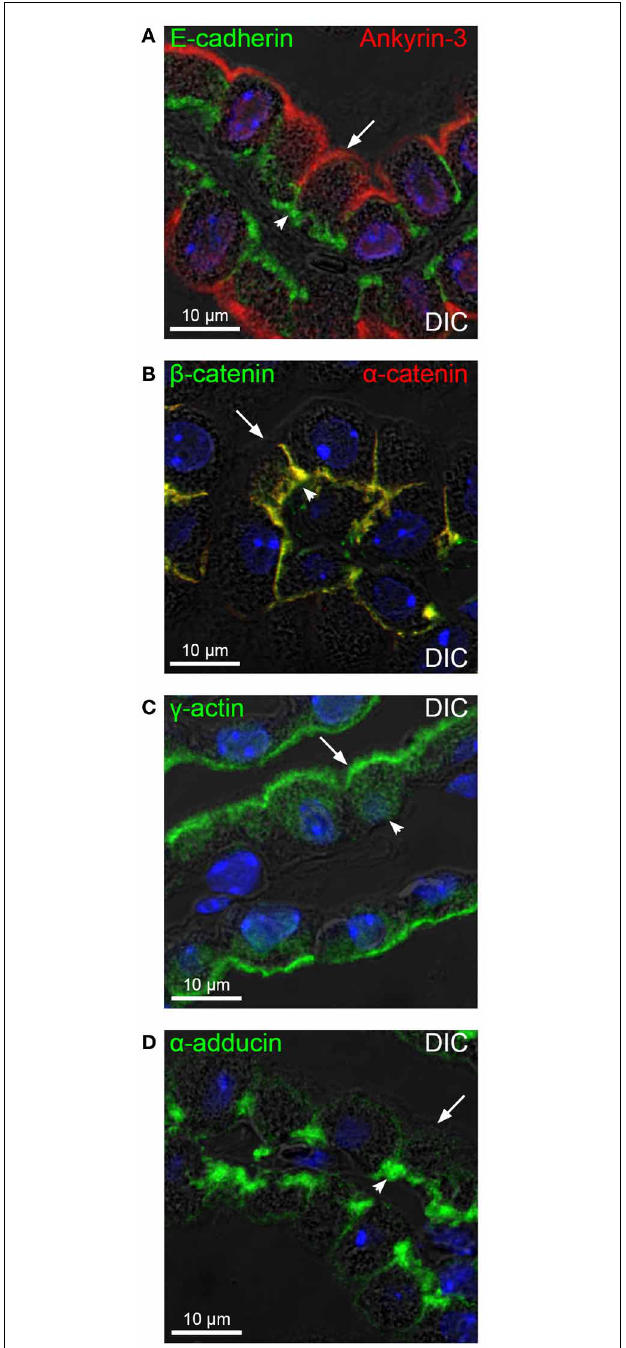
FIGURE 2 | Expression of E-cadherin, catenins, γ -actin, and α -adducin in the CPE. Mouse brain sections were immunostained for E-cadherin, β -catenin, γ -actin, and α -adducin (in green), as well as ankyrin-3 and α -catenin (in red). (A) Immunohistochemical double immunolabeling for E-cadherin and ankyrin-3 overlayed on the corresponding DIC image. (B) Double immunolabeling for α - and β -catenin, overlaid on the corresponding DIC image. (C,D) Immunolabeling and DIC images for γ -actin and α -adducin, respectively. Arrows indicate the luminal membrane, while arrowheads indicate the basolateral membrane. Cell nuclei were visualized by Topro nuclear staining (blue).